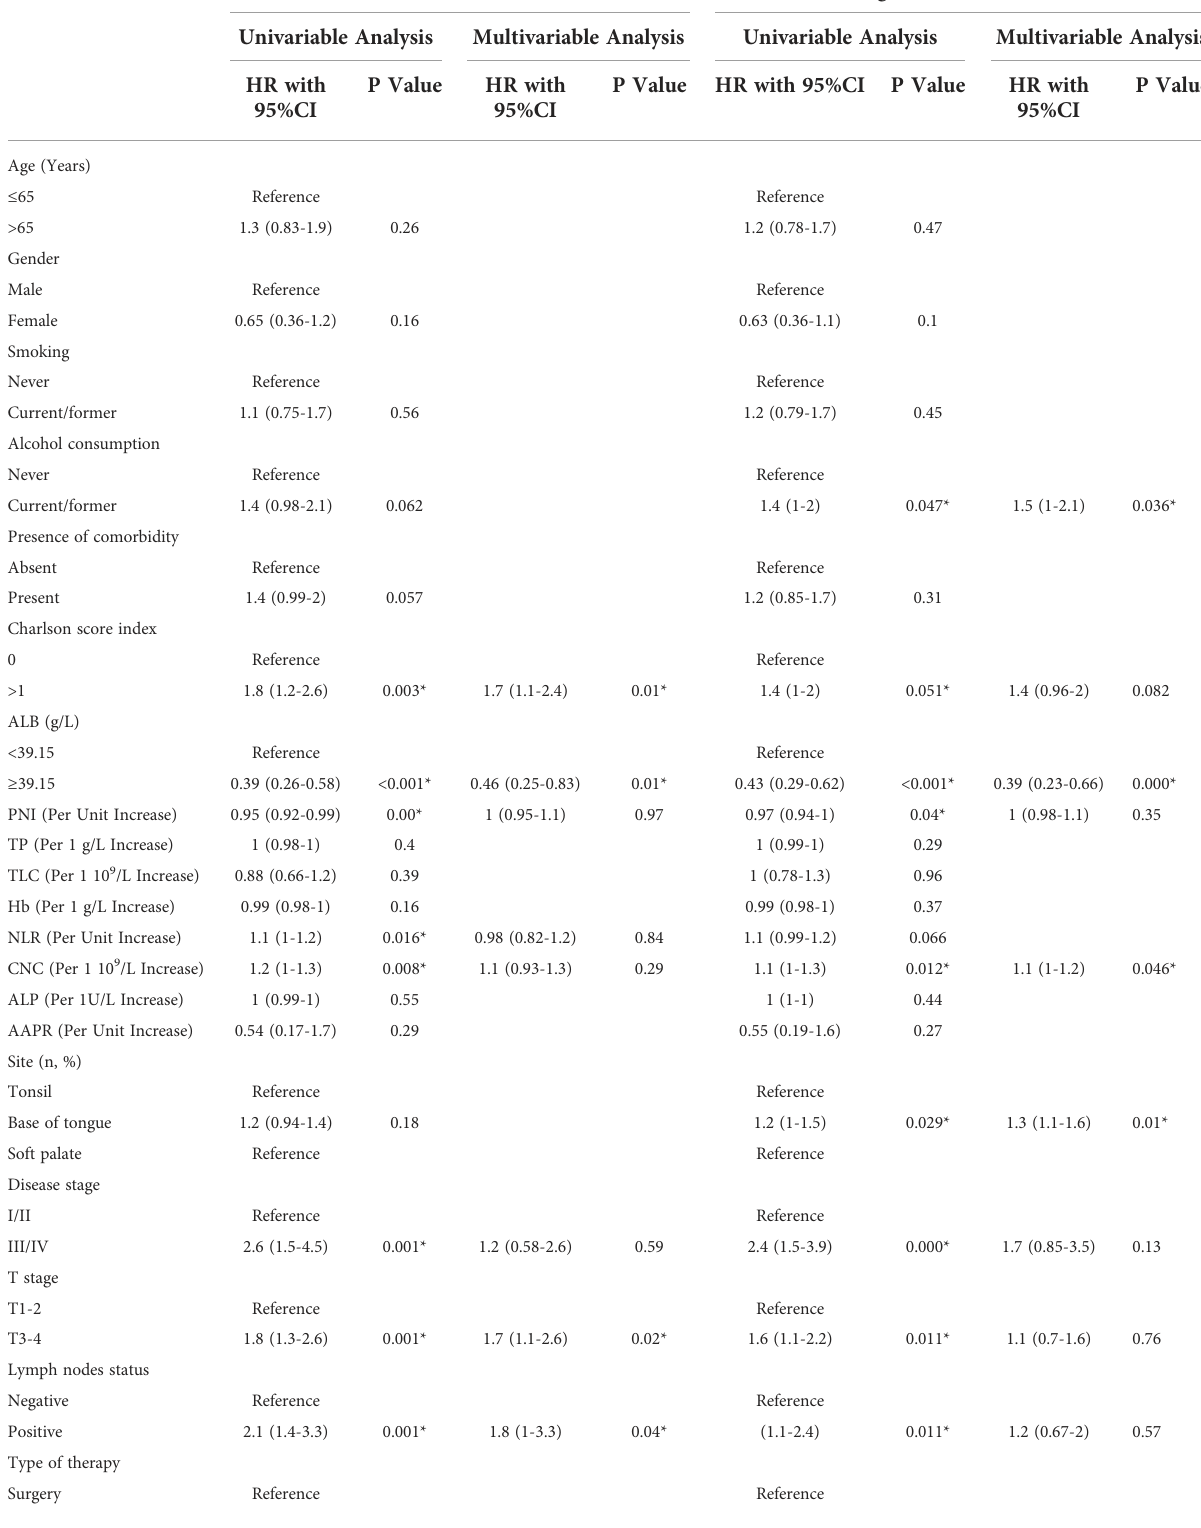
TABLE 3 Univariate and multivariate survival analyses between clinicopathologic characteristics and survival on OS and DFS in patients with